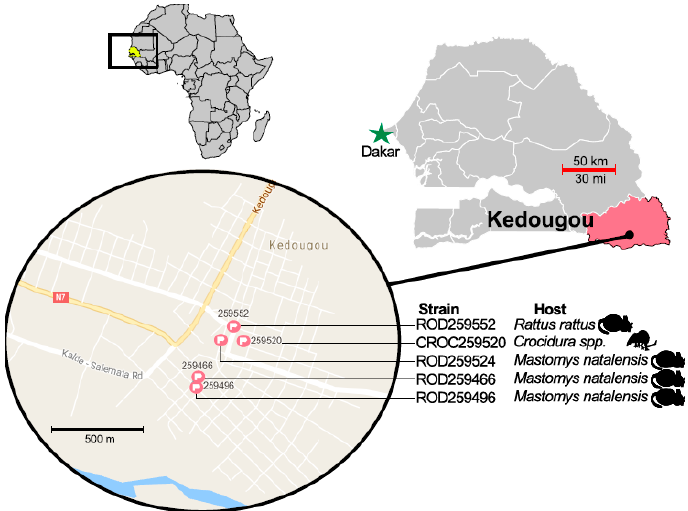
Figure 1. A map of Kedougou with the locations of the five captured Usutu virus-positive mammals.